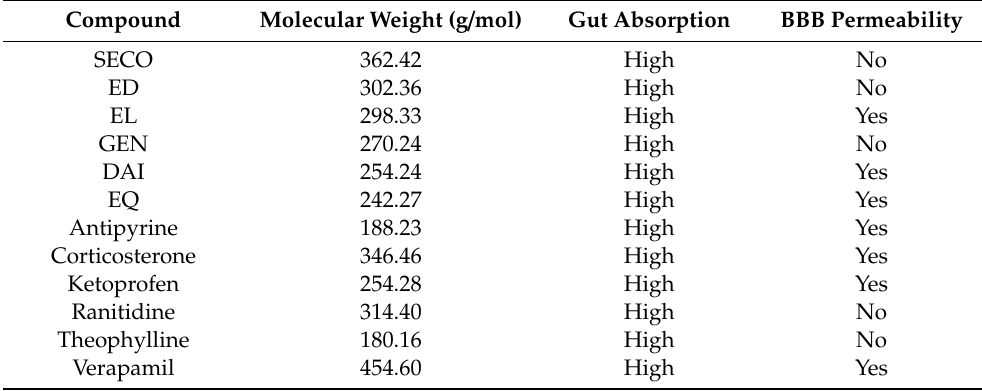
Table 1. In silico SwissADME predictive permeability of parent polyphenols and their microbial metabolites in the gut and blood–brain barrier